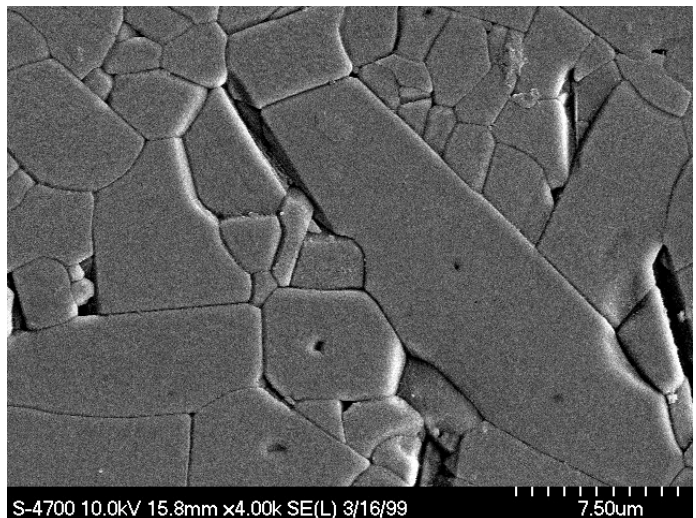
Figure 1. Microstructure of alumina with a purity of 99.7% sintered at 1650 °C.